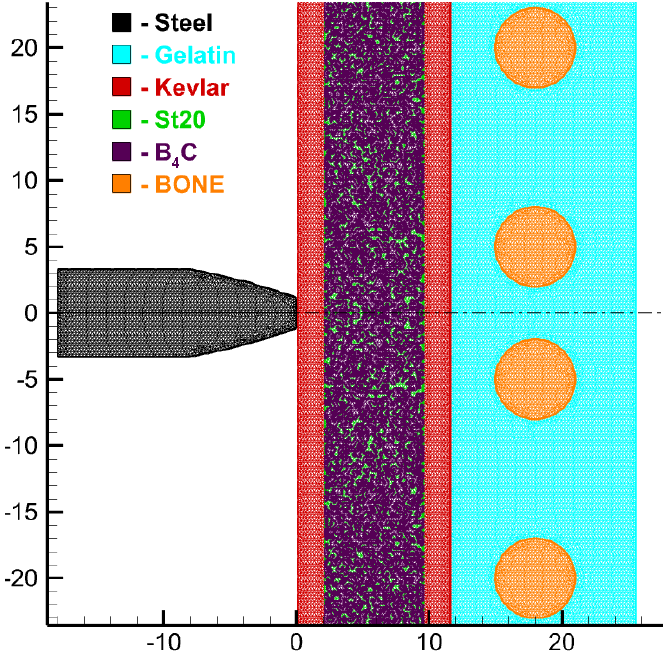
Fig. 3. The protective element with a plate of heterogeneous material obtained by the random distribution of ceramics in the steel volume with a given concentration, model 3.